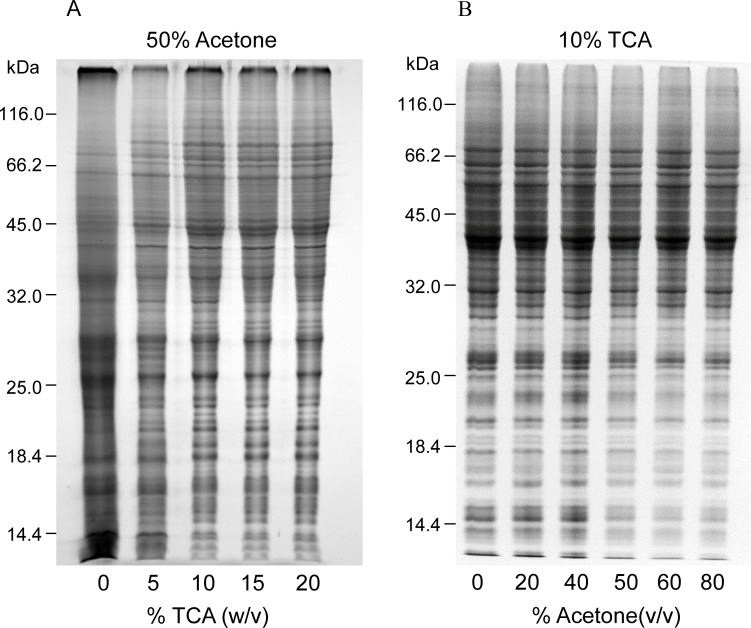
Optimization of TCA/acetone ratio used in the modified method.Equal amounts (ca. 30 μg) of maize root proteins were analyzed by SDS-PAGE (12.5% resolving gel). Protein was stained using CBB. A, final acetone concentration was 50% (v/v), but TCA concentration varied from 0–20% (w/v) in the aqueous mixture. B, final TCA concentration was 10% (w/v), but acetone concentration varied from 0–80% (v/v) in the aqueous mixture.